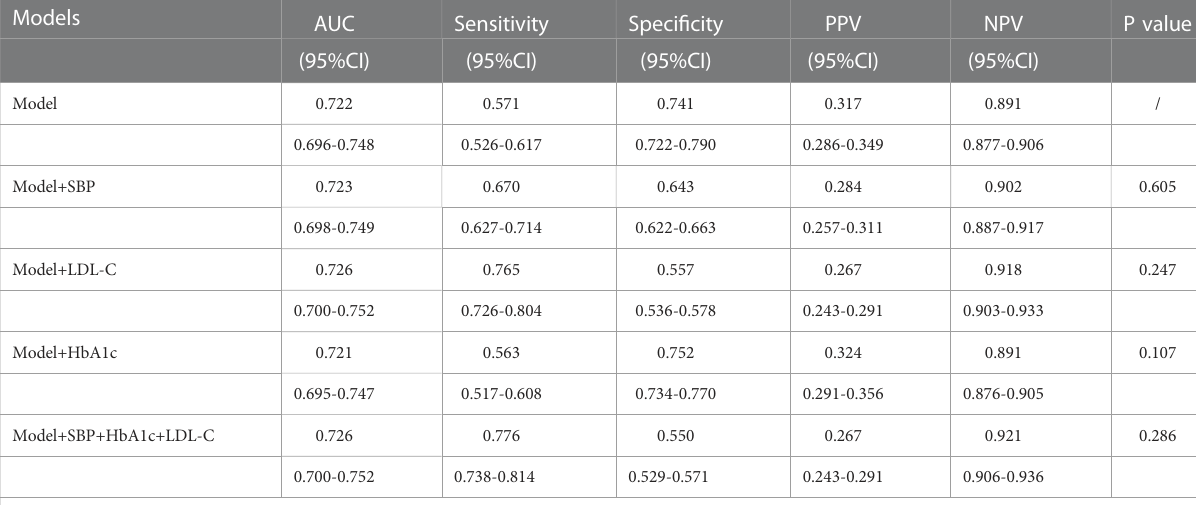
TABLE 5 Model performance statistics in training dataset.